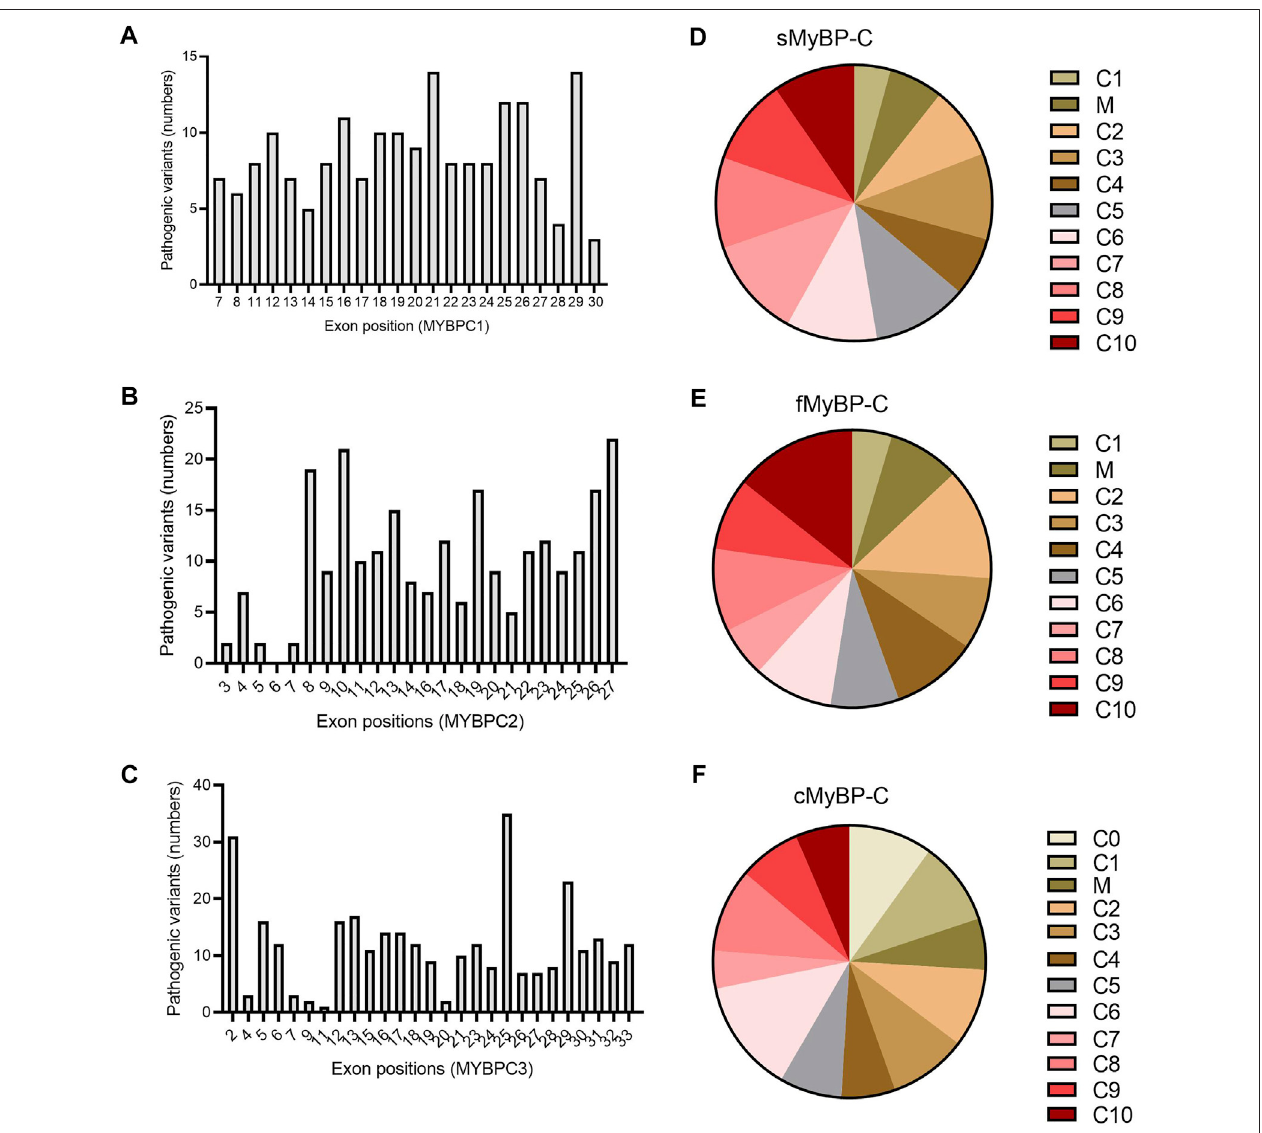
FIGURE8| Prevalenceofexonsinthegenesand domains ofproteinssusceptibletopathogenicvariants in MYBPC geneparalogs. In MYBPC1 (A) , exons21and 29hadthehighestnumberofhitswithpathogenicvariants.However,in MYBPC2 (B) ,exons8,10,19,26,and27weretheprevalenttargetswithpathogenicvariants.In MYBPC3 (C) , exon 2 and exon 25 had the highest number of variants. In terms of domain-wise frequency of pathogenic variants, the C6 domain was the most highly mutated domain leading to pathogenic variants across paralogs, followed by C5 and C7 in sMyBP-C (D) , C2 and C10 in fMyBP-C (E) and C0, C1, and C6 in cMyBP-C (F)